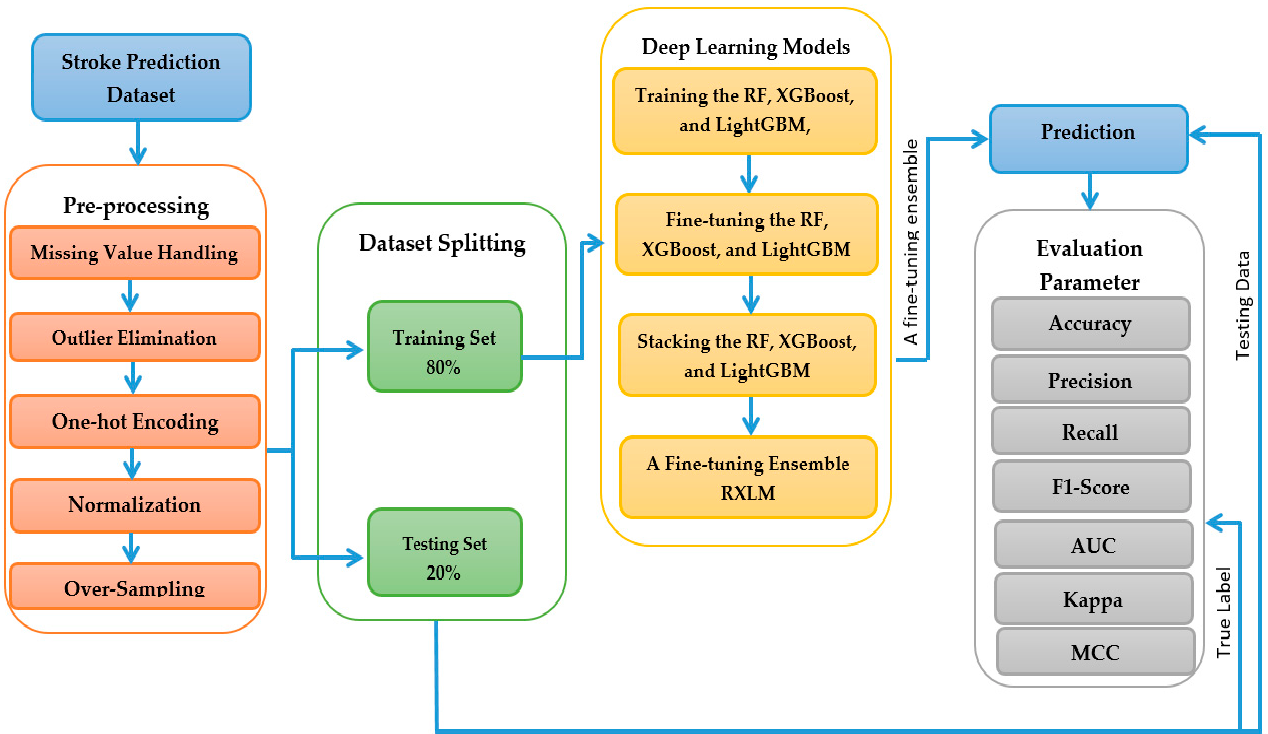
Figure 1. The methodology for the tuning ensemble RXLM for cerebral stroke prediction.